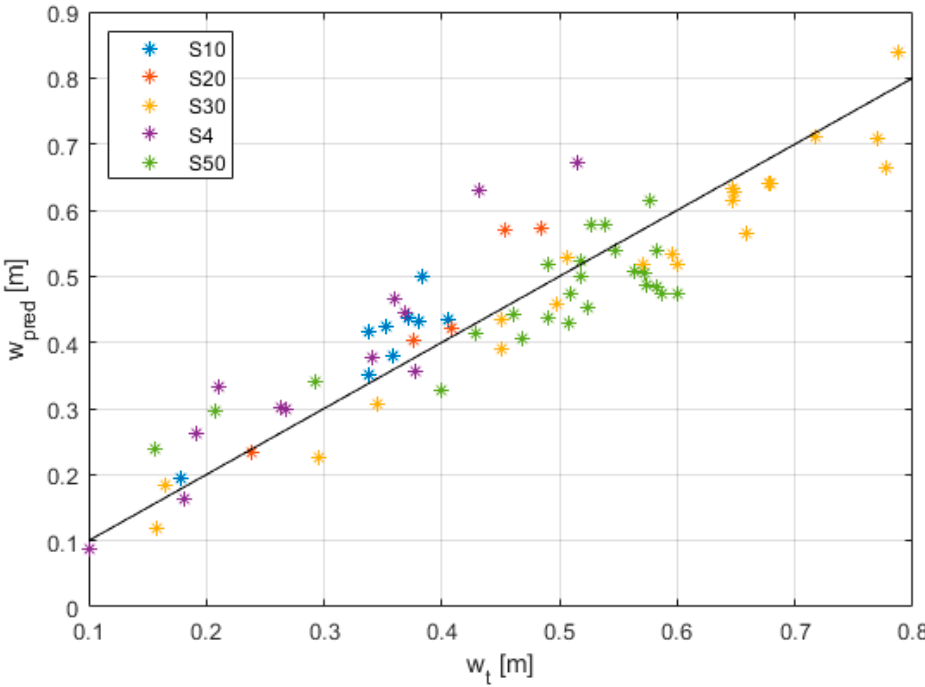
Figure 13. Topographic vs predicted water depth for the five sections of the study sample.